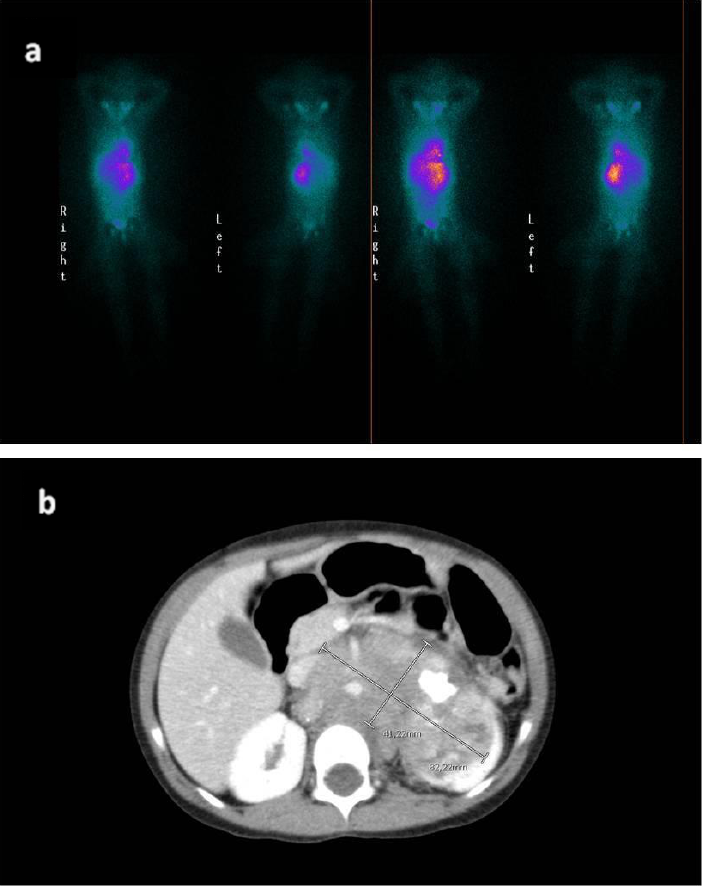
Figure 1. ( a ) Meta-(radioiodinated)iodobenzylguanidine showing abdominal mass uptake. ( b ) CT scan showing neuroblastoma.